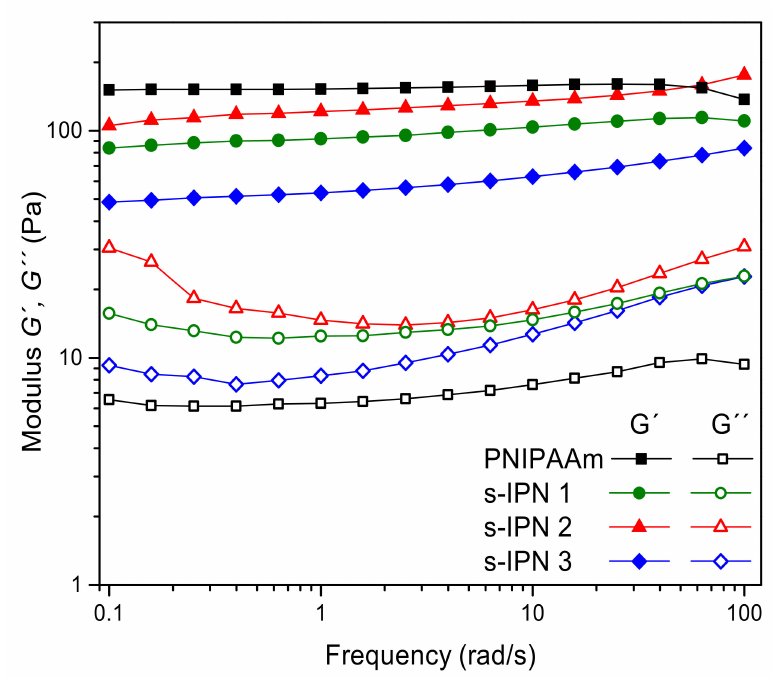
Figure 5. Rheological measurements of neat PNIPAAm hydrogel and s-IPN